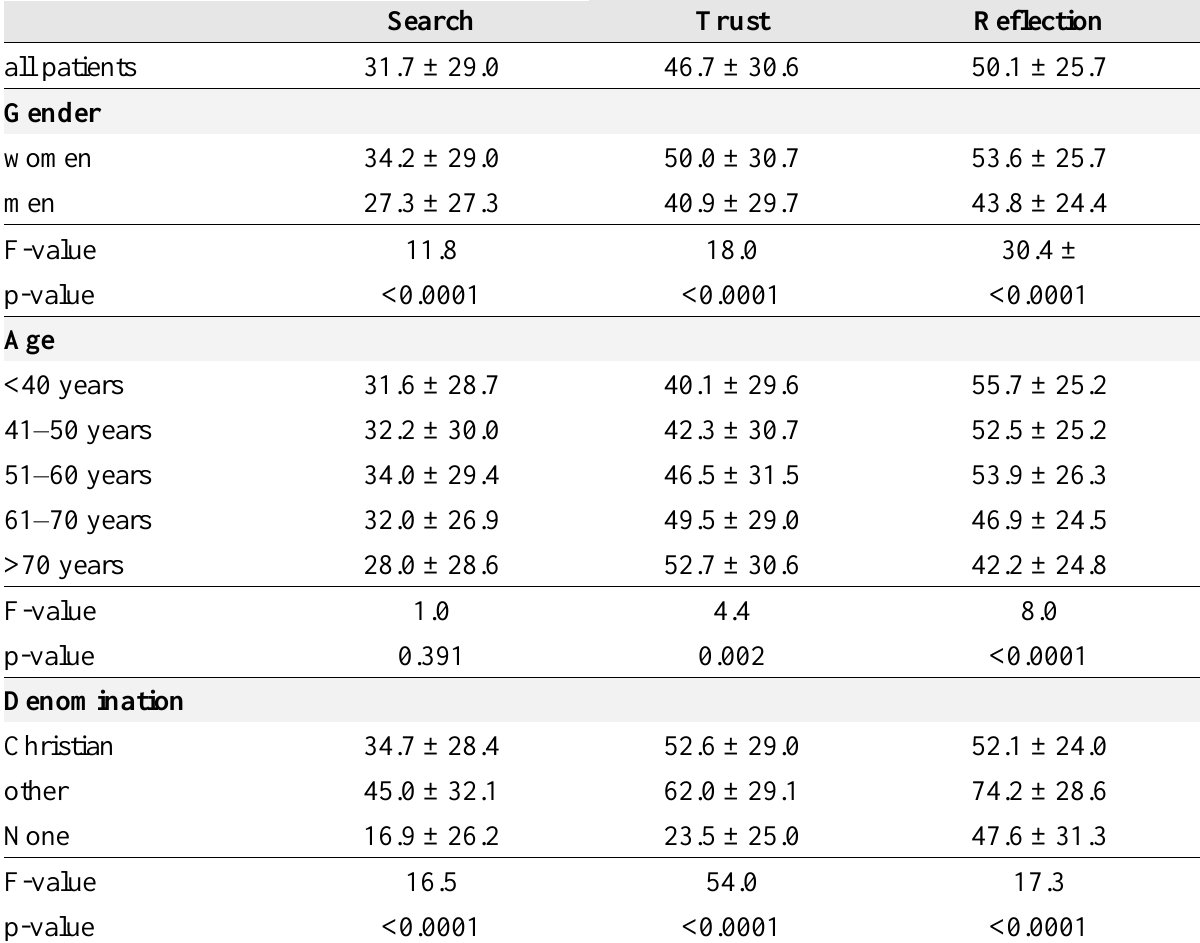
Data refer to 888 German patients (see Table